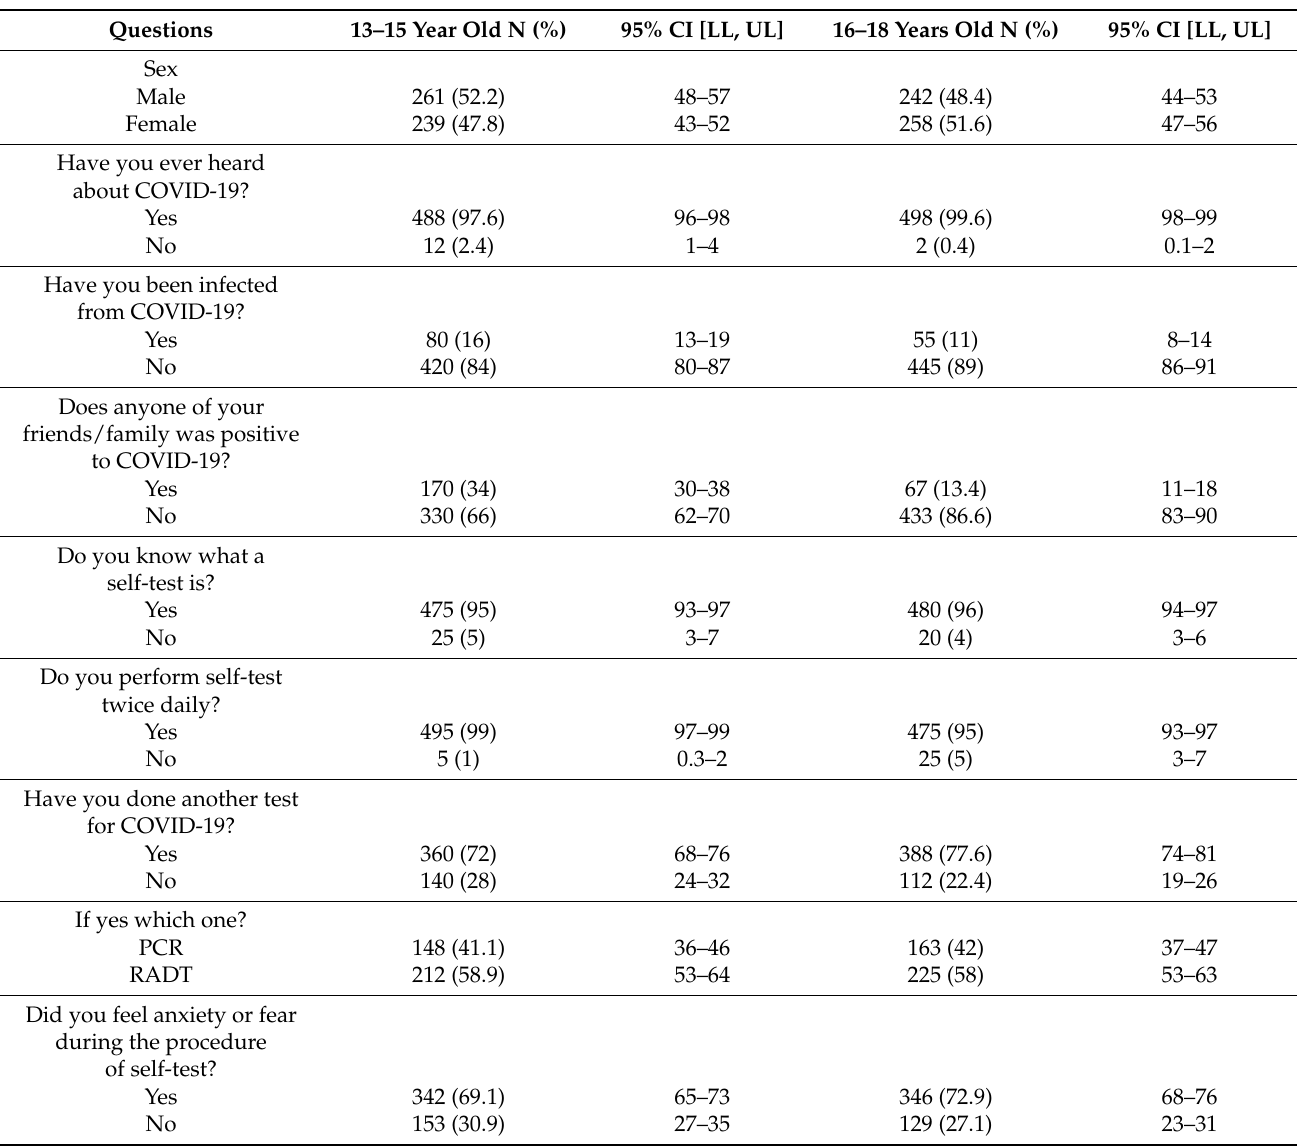
Table 1. Descriptive statistics of the answers divided into two age